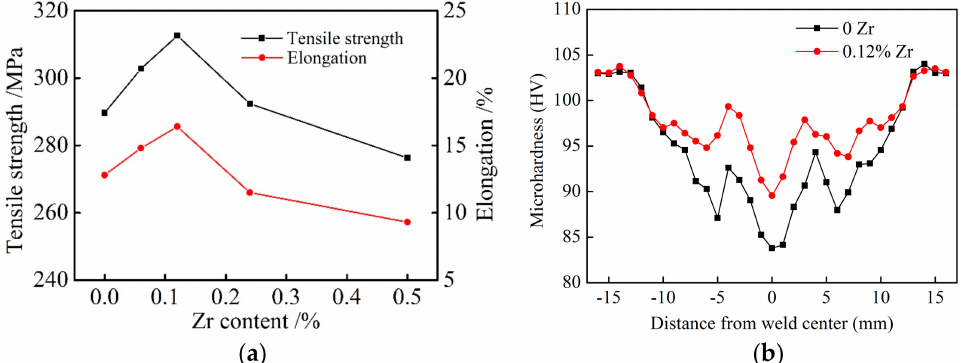
Figure 10. Mechanical properties of the welded joints with 1.2 mm Al-5Mg- x Zr wire electrodes: ( a ) tensile strength (fracture location: weld zone); ( b ) microhardness distribution across the welded